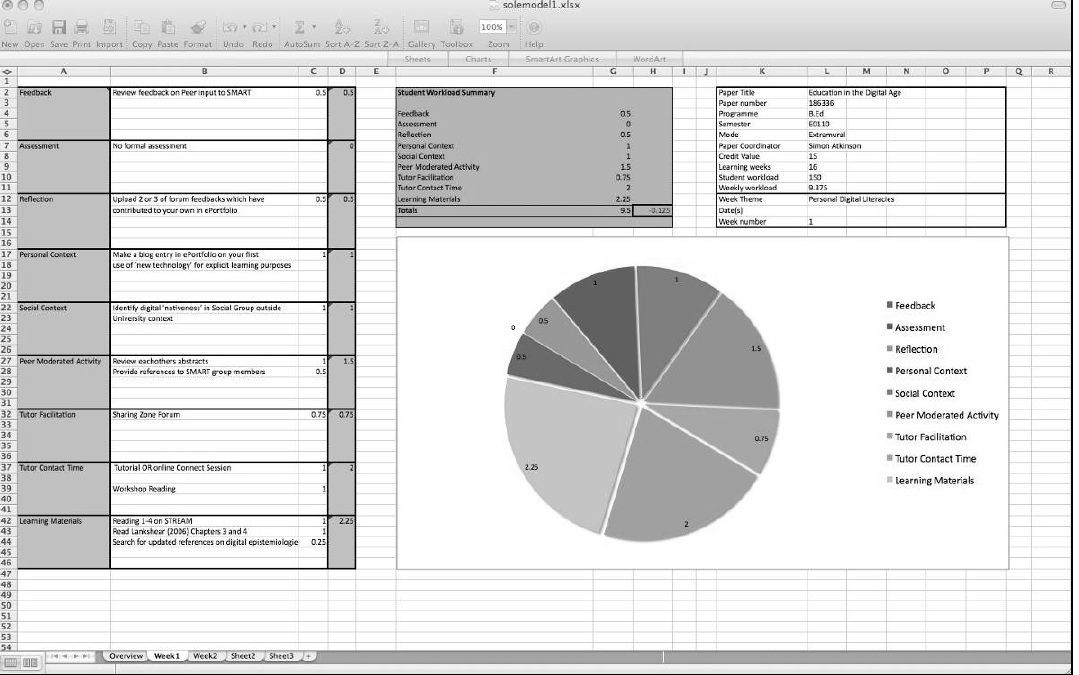
Figure 3 . The SOLE toolkit (Version